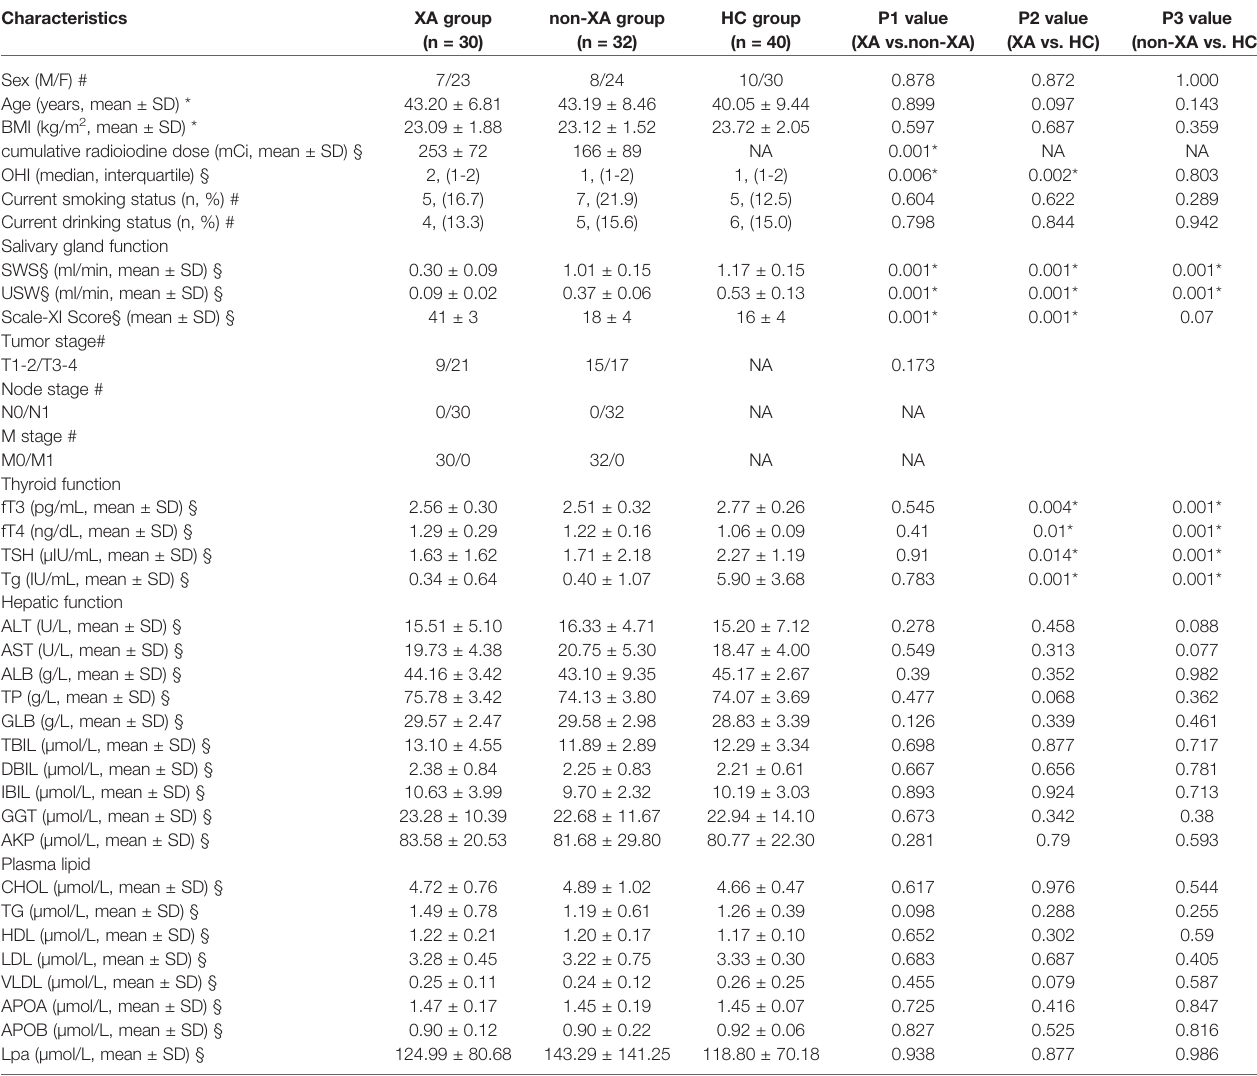
TABLE 1 | Clinical and demographic features.